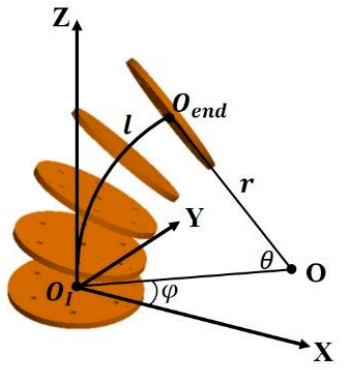
Figure 4. Illustration of the CKM kinematics parameters.